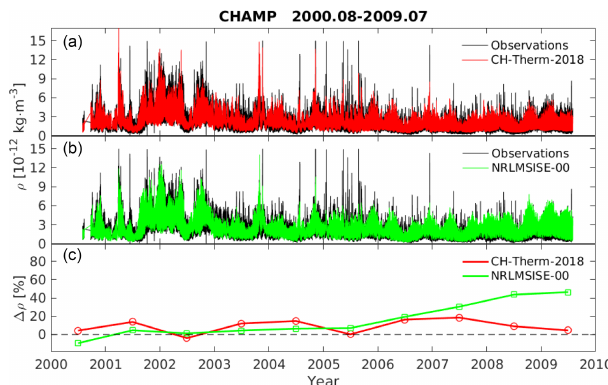
Figure 6. Panel (a) shows the CH-Therm-2018 model-predicted mass density (red) and CHAMP observations (black) from Au- gust 2000 to July 2009. Panel (b) shows the same density but for the NRLMSISE-00 model (green) and CHAMP observations (black). Panel (c) gives the annual average relative differences between the model estimates and CHAMP